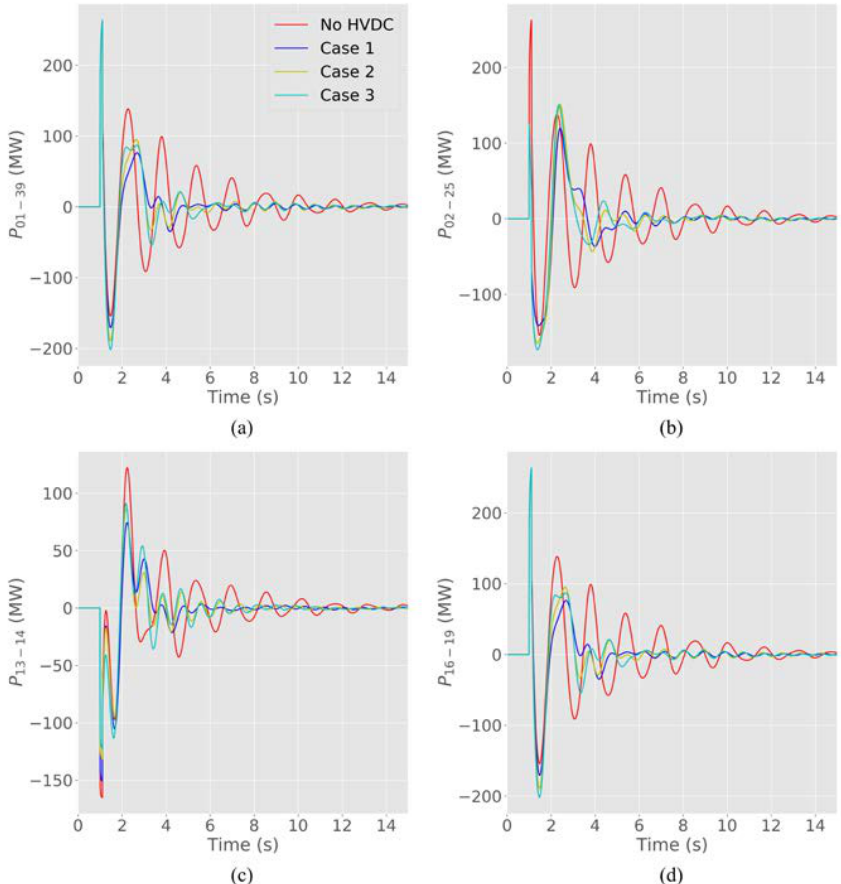
Figure 5. The power oscillations on transmission lines. ( a ) Line 01–39; ( b ) Line 02–25; ( c ) Line 13–14; ( d ) Line 16–19.